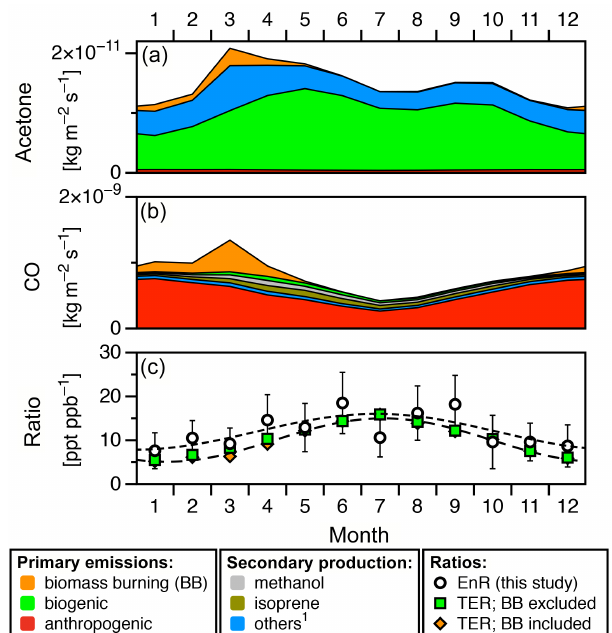
Figure 11. Southeast Asian emission rates of (a) acetone and (b) CO according to the ECCAD database for the time period 2005– 2010. (c) Volume ratio of total emissions of acetone and CO dis- played for three different scenarios and compared to EnR derived from IAGOS–CARIBIC in situ data. A sinusoidal function (dashed line) is fitted to the monthly means of EnR and total emissions vol- ume ratio (TER), respectively (see Fig. 10). 1 Includes propane, isobutane, isopentane and seven monoterpene species as precursors of acetone and ethene, ( ≥ C 4 ) alkanes, ( ≥ C 3 ) alkenes and monoter- penes as precursors of